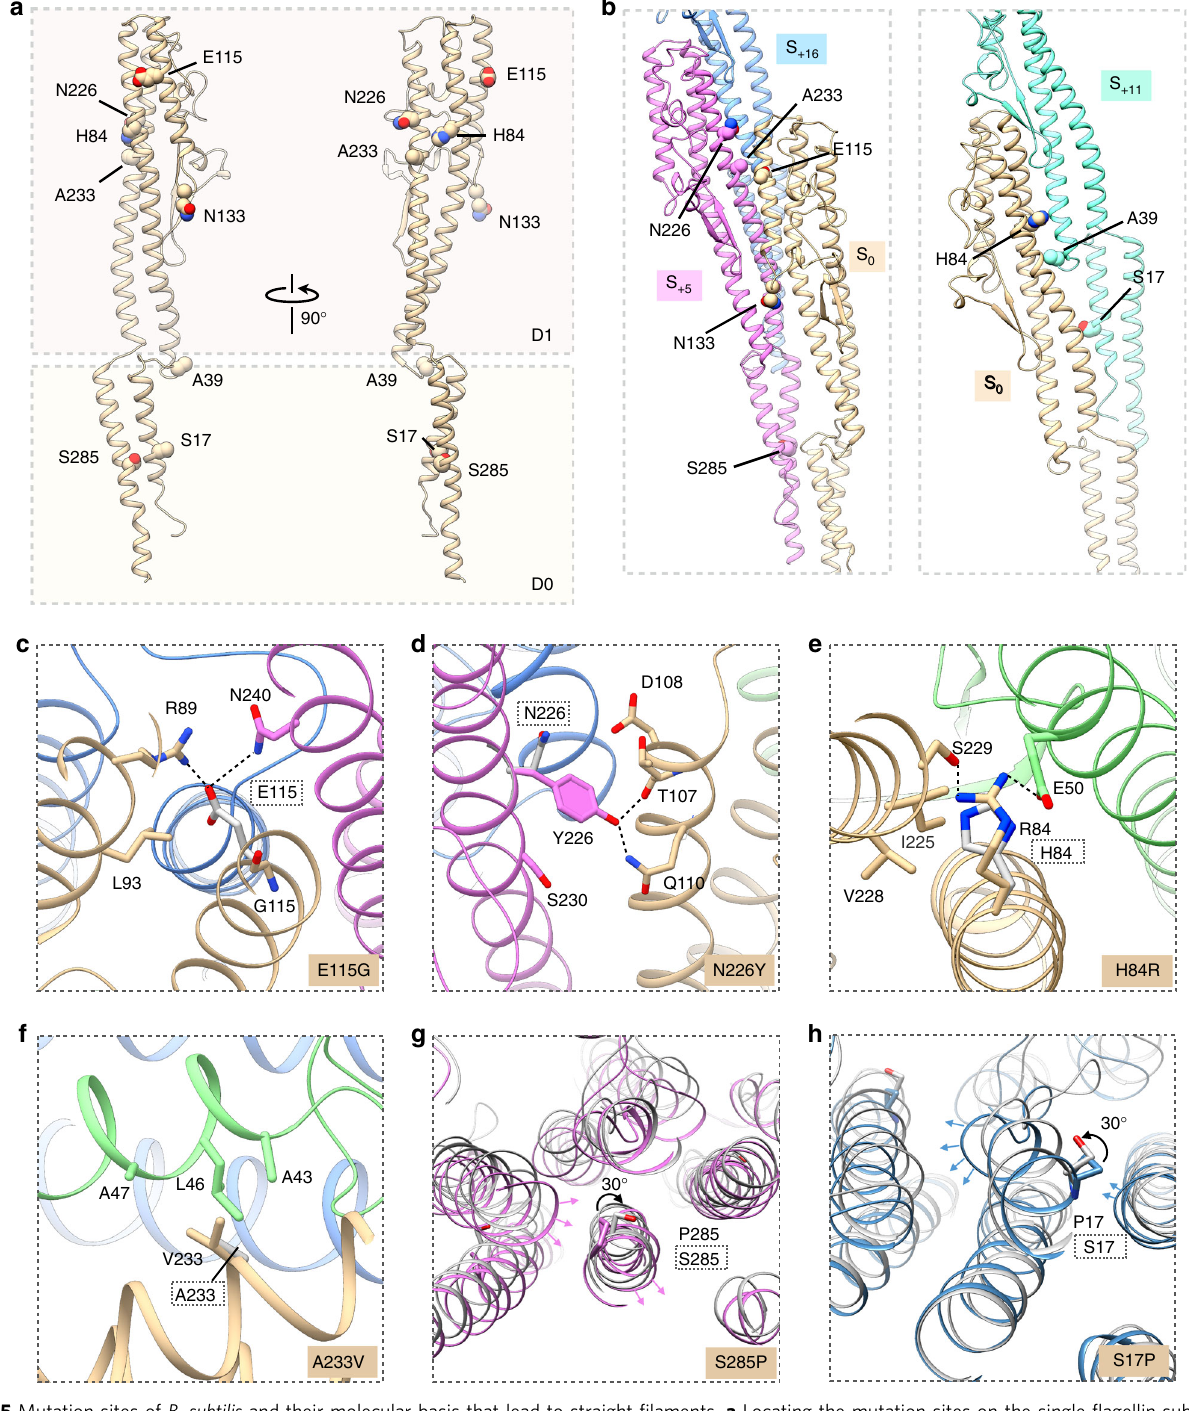
Fig. 5 Mutation sites of B. subtilis and their molecular basis that lead to straight fi laments. a Locating the mutation sites on the single fl agellin subunit. b Locating the mutation sites on the 5-start interface ( left ) and the 11-start interface ( right ). c – f Subunits S 0 , S +5 , S +11 and S +16 are colored in dark yellow , purple , green and blue , respectively. Un-mutated residues are shown in gray , and adapted from the other mutants in the same hand. Mutation sites for: left-handed mutation E115G c , right-handed mutation N226Y d , right-handed mutation H84R e , and right-handed mutation A233V f . g Top view of two mutant structures N226Y ( gray ) and S285P ( purple ) aligned by upper part of D0 domain (amino acids 18 – 32 and 268 – 284). h Top view of two mutant structures N226Y ( gray ) and S17P ( blue ) aligned by the same upper part of D0